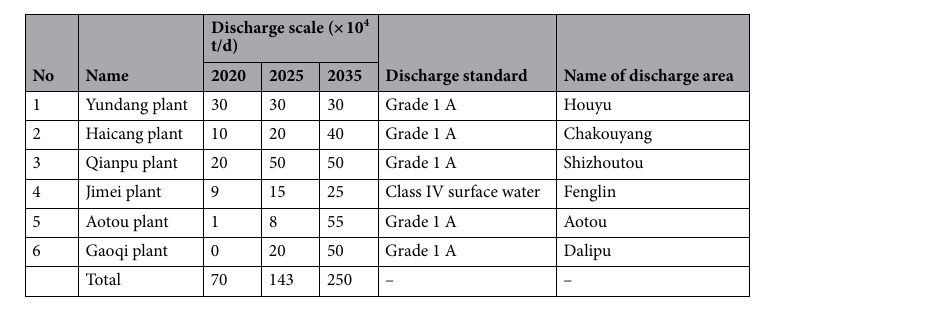
Table 1. Discharge scale and discharge area of wastewater treatment plants in